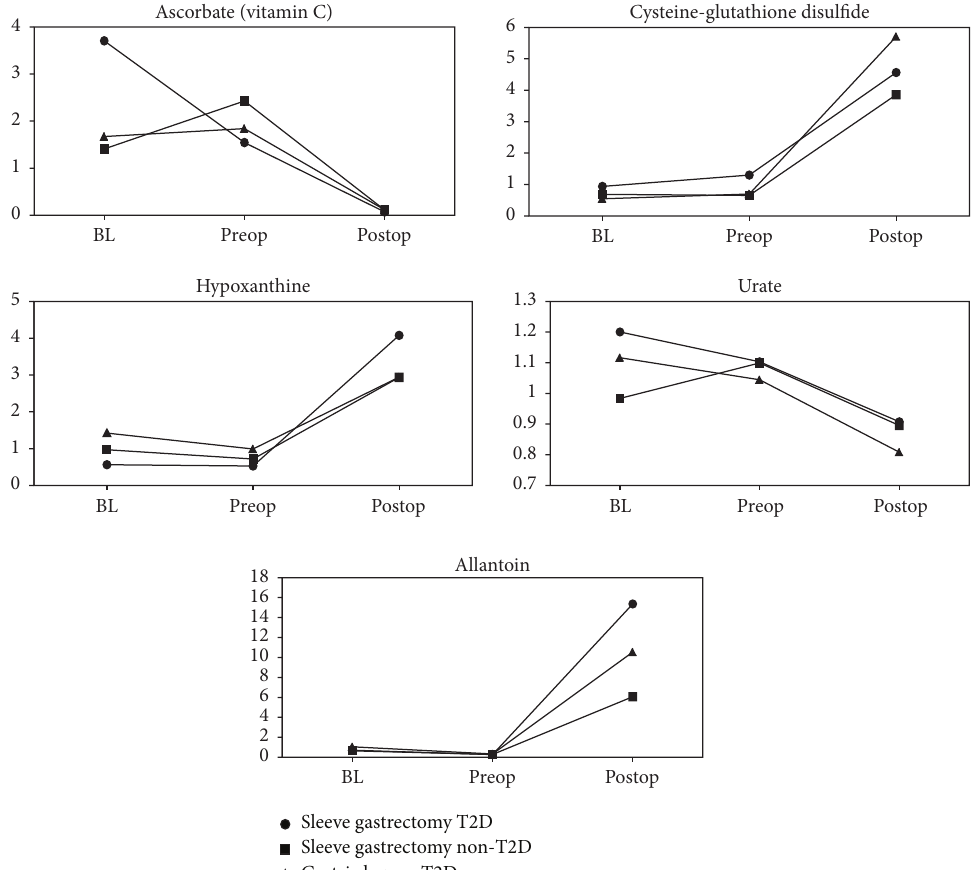
Figure 2: Postsurgery metabolic changes. All shown metabolites meet the conservative criteria of 𝑃 < 0.05 and an estimated false discovery rate of less than 5% ( 𝑞 < 0.05